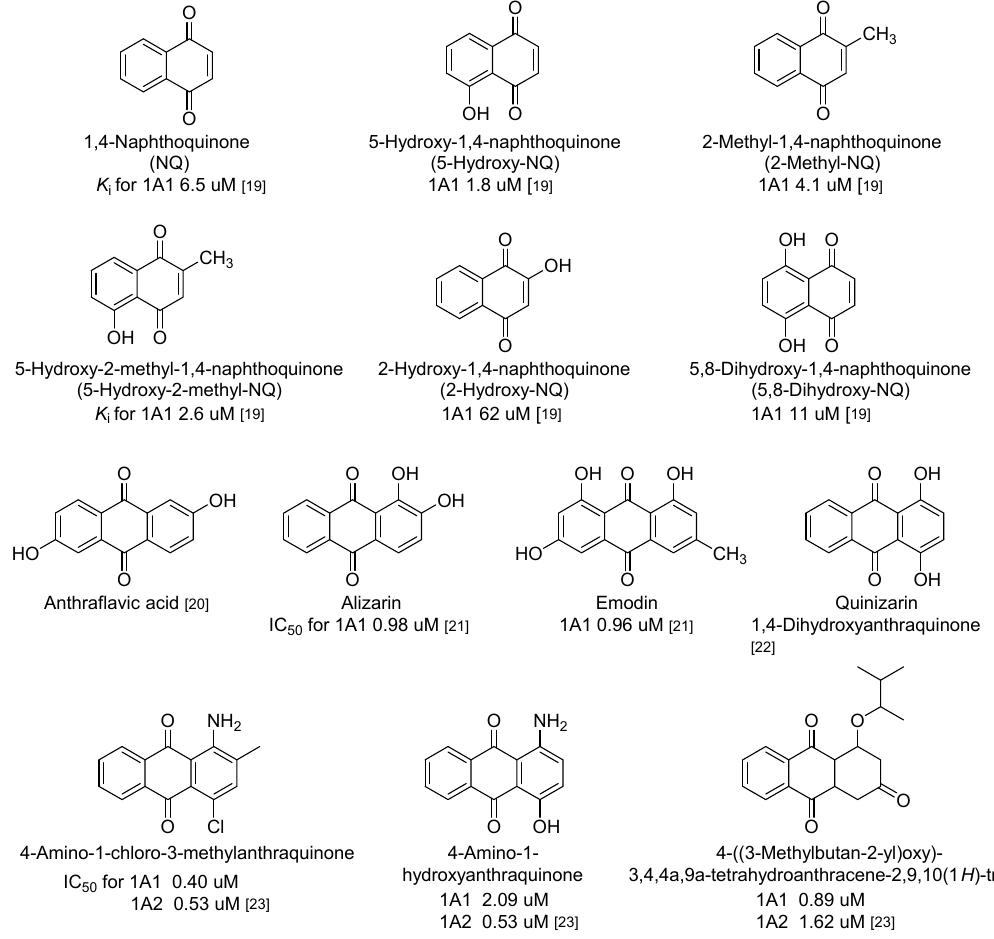
Figure 2. Structures of naphthoquinone and anthraquinone